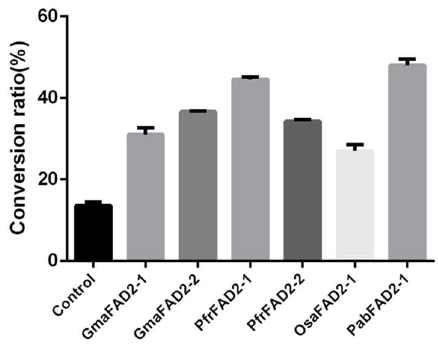
Figure 4. The conversion of oleic acid into linoleic acid in Saccharomyces cerevisiae cells overexpressing the seed-specific or high-expressed FAD2 genes in soybean ( GmaFAD2-1 and GmaFAD2-2 ), perilla ( PfrFAD2-1 and PfrFAD2-2 ), rice ( OsaFAD2-1 ), and spruce ( PabFAD2-1 ). The control represented the conversion ratio in yeast with the empty vector pYES2. The conversion ratios were calculated based on the results of Gas Chromatography (GC) in Figure S3 of File S3. The p -values are also presented in Figure S3 in File S3.